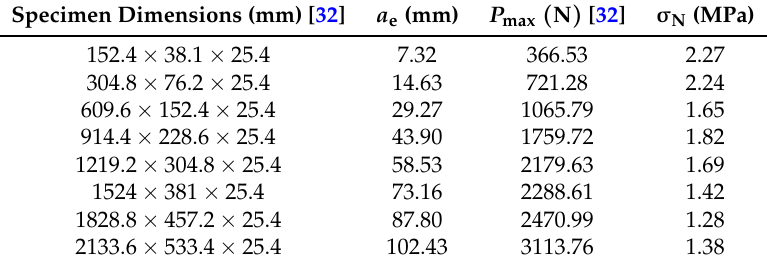
Table 1. Concrete specimen and test